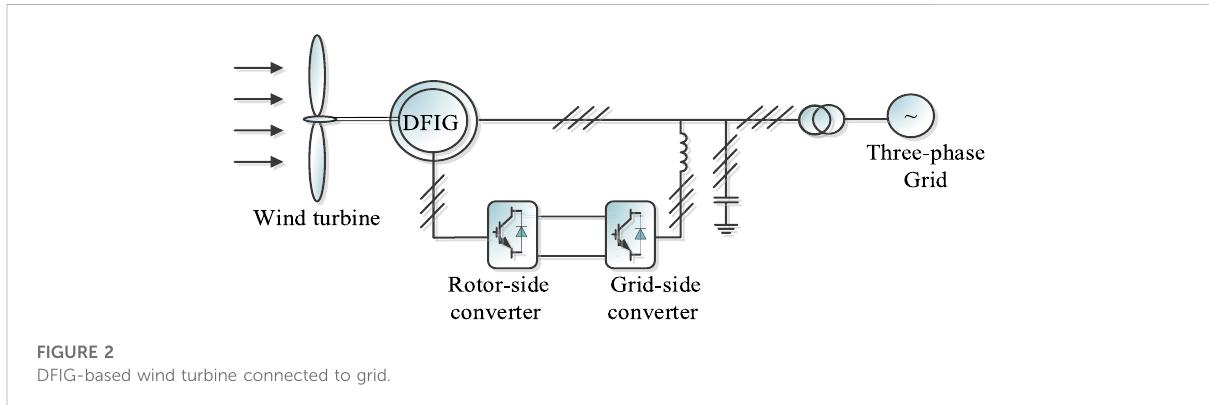
FIGURE 2 DFIG-based wind turbine connected to